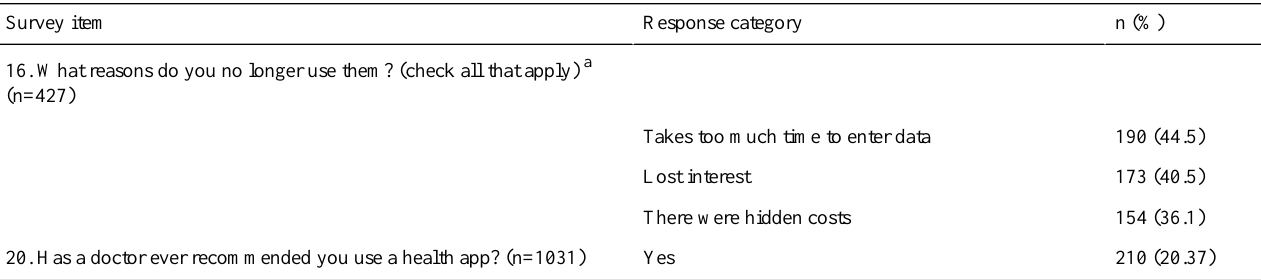
a Table 2 is an abridged version; see Multimedia Appendix 2 for the full list of items and